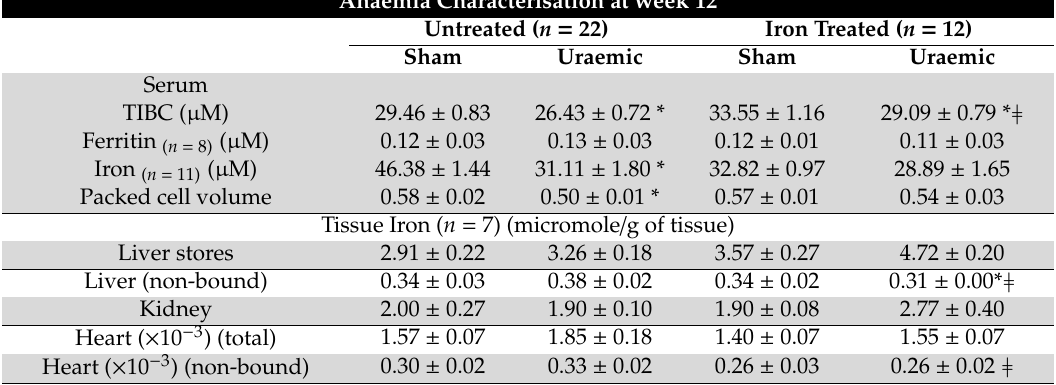
Table 2. Markers of iron status in sham and uraemic animals with and without iron therapy. Data are presented as mean ± SEM. * p < 0.05; sham versus uraemic. ǂ p < 0.05; uraemic untreated versus treated. TIBC = total iron bonding capacity.